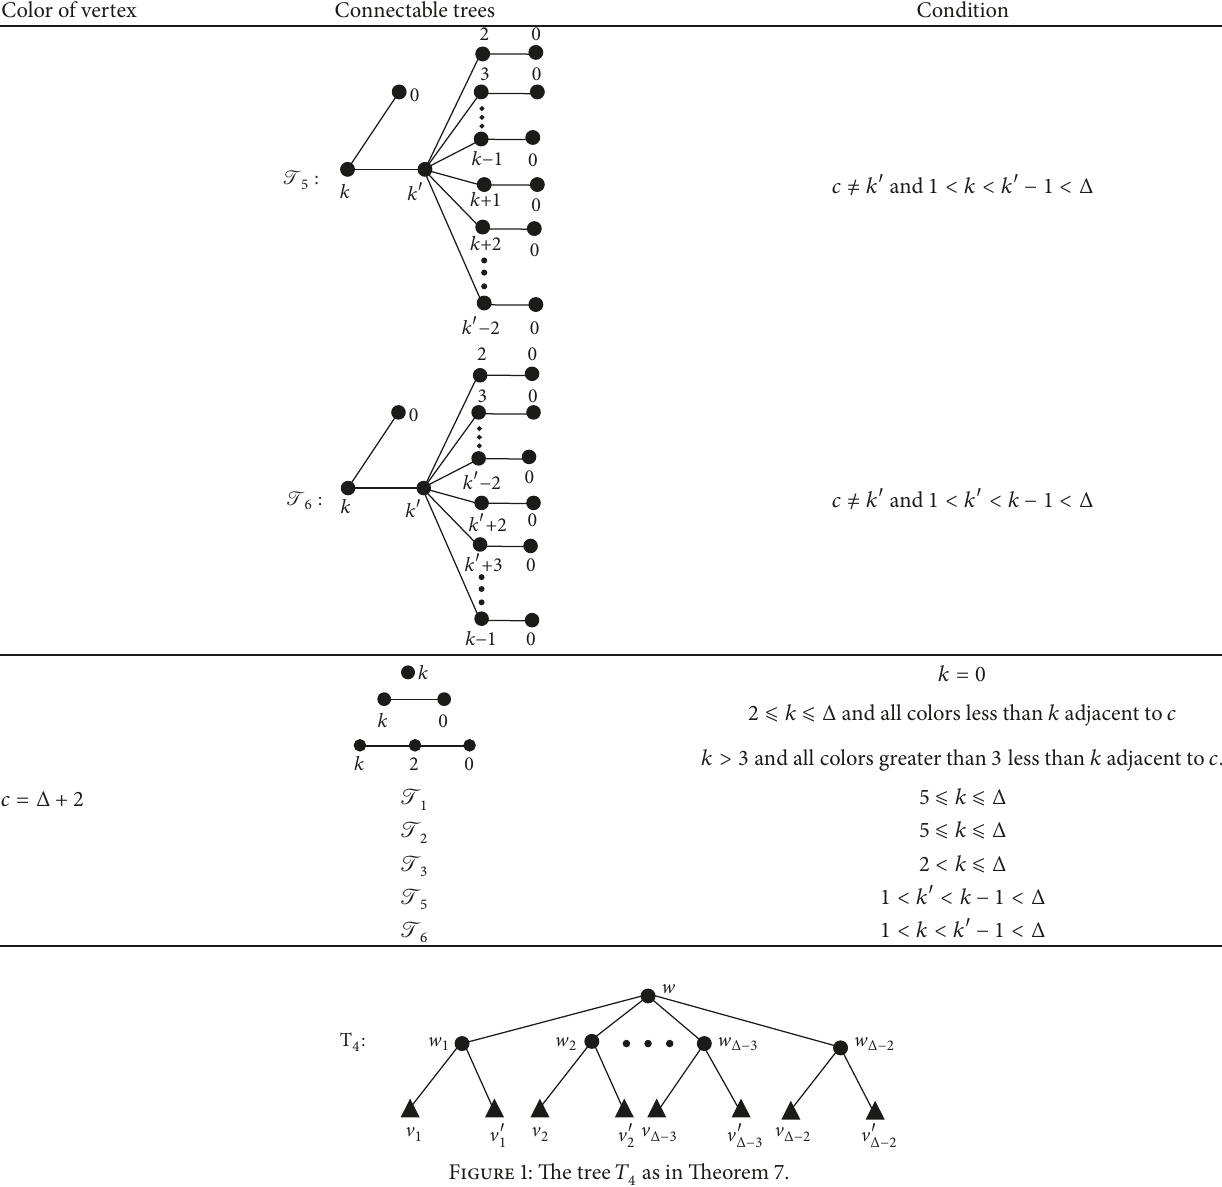
Figure 1: The tree 𝑇 4 as in Theorem